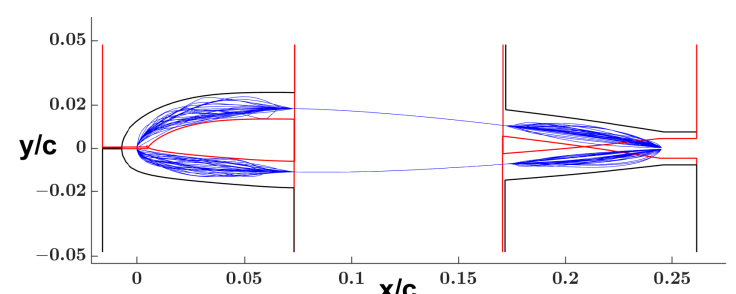
Table 17. Initial and ‘ ’global’’ morphed NCA